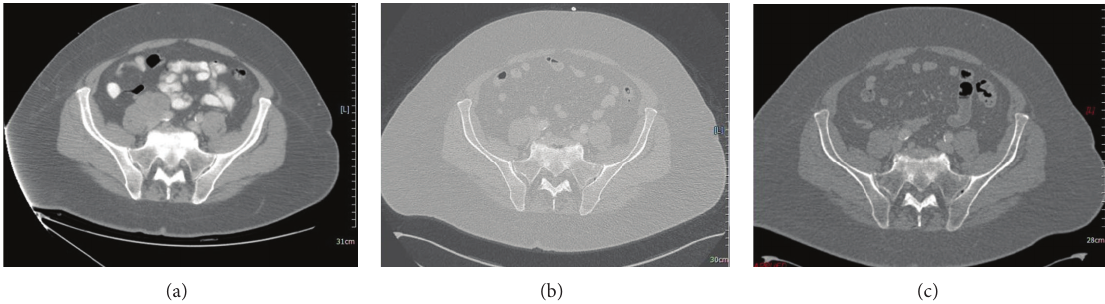
Figure 1: CT scan of pelvis showing right mass at diagnosis, after-chemotherapy and after-radiotherapy.